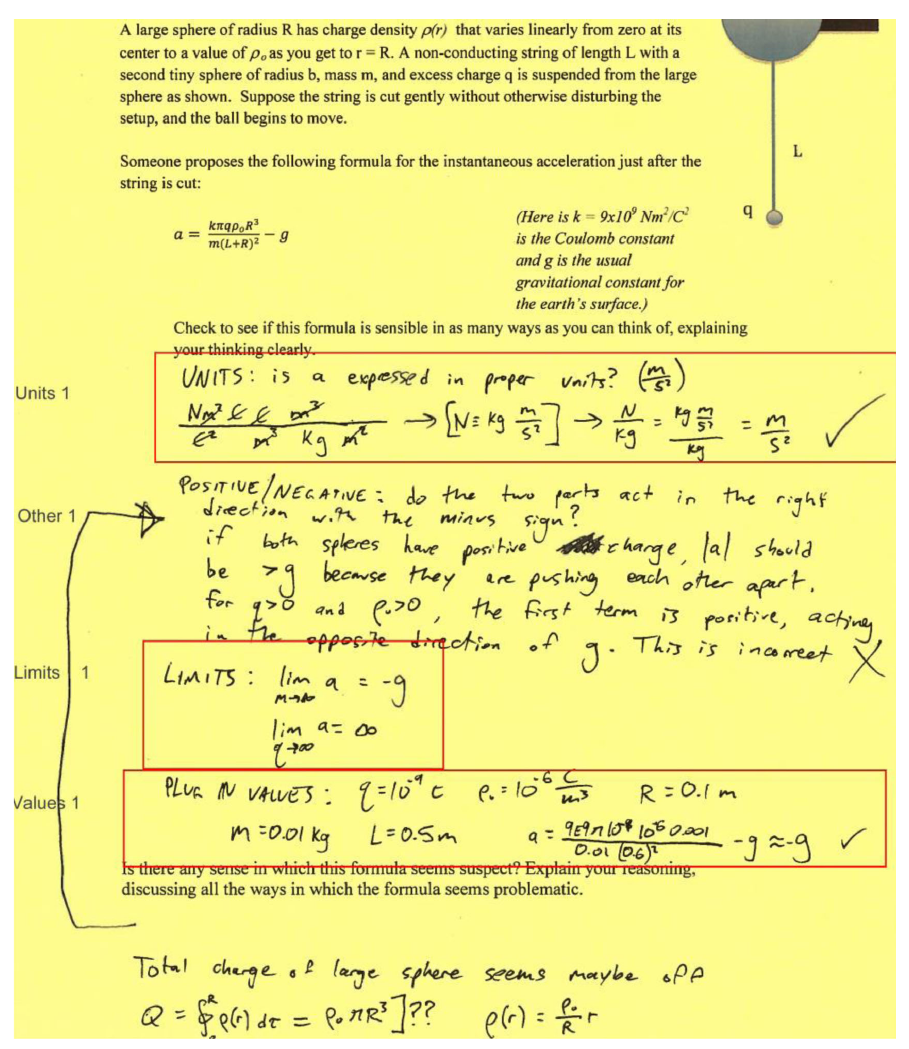
FIG. 1. Example prompt, student response, and researcher